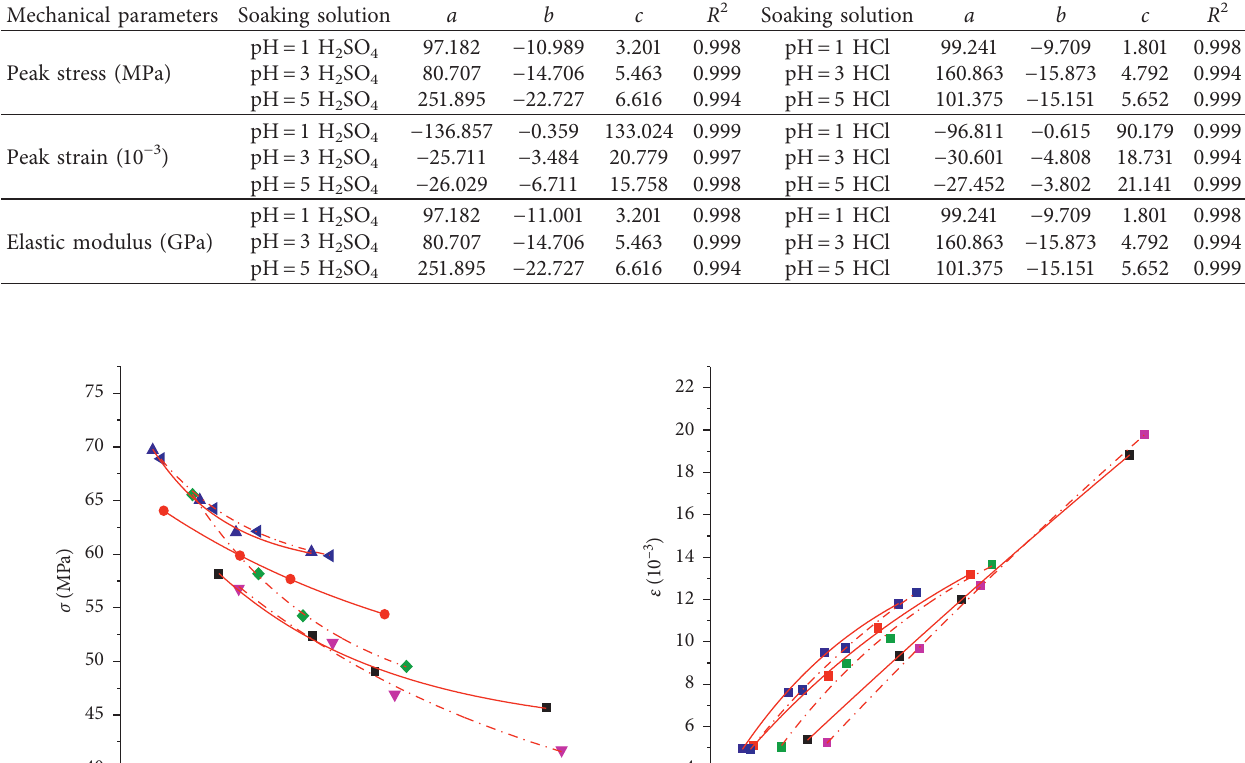
Table 8: Fitting parameters of relationship between damage variable and peak strength.